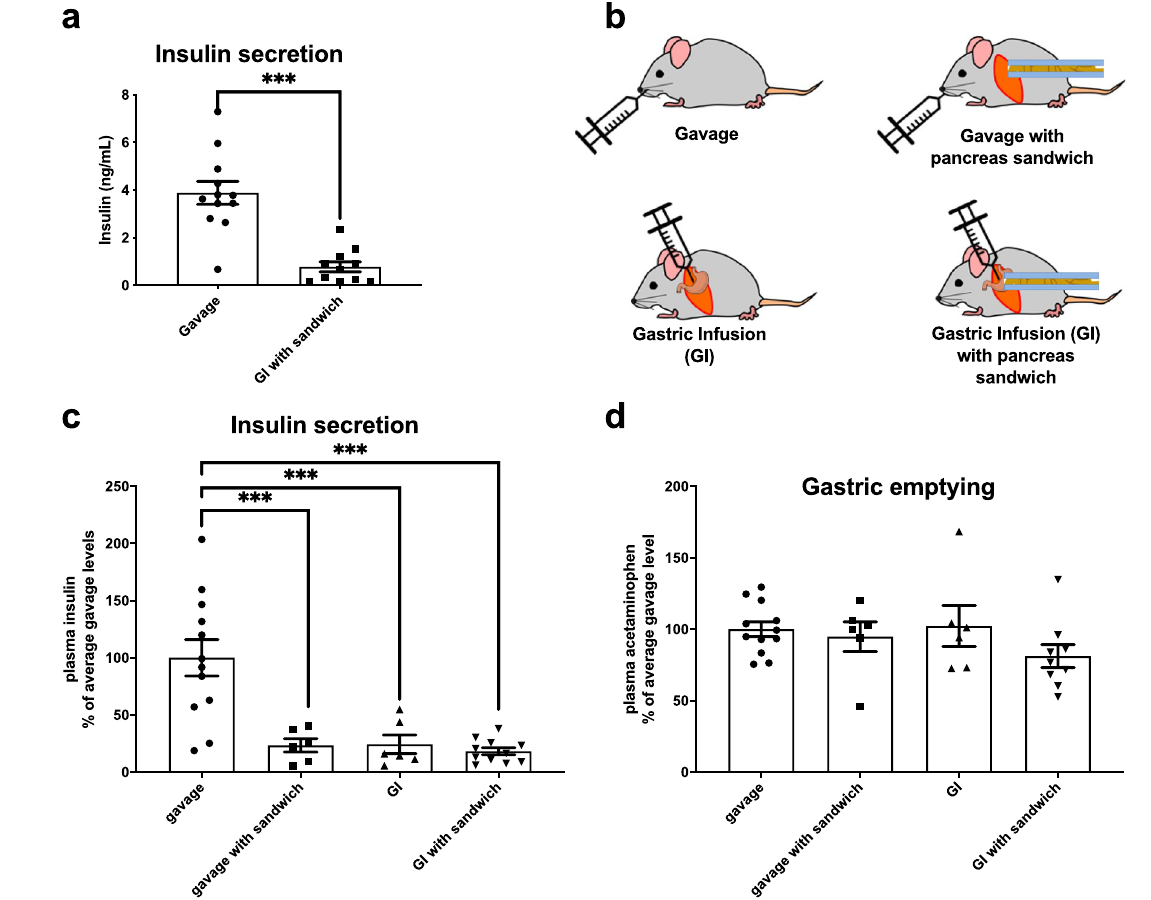
Figure 4. Impact of surgery. ( a ) Glucose-stimulated insulin secretion on mice stimulated by gavage or by gastric infusion after having the pancreas exteriorized. ( b) Diagram of the different conditions used for analysis in panels ( c ) and ( d ). Insulin secretions ( c ) and gastric emptying ( d ) in mice that were glucose-stimulated by either gavage, gavage with pancreas exteriorization (sandwiching), gastric infusion and gastric infusion with pancreas exteriorization (sandwiching). ***p <